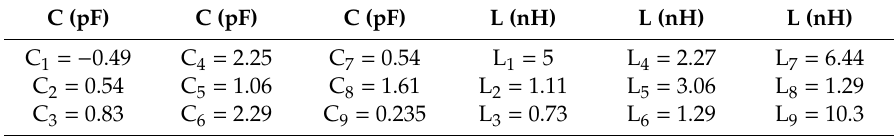
Figure 11. ( a ) Equivalent lumped circuit of the microstrip band stop filter based on gradient line EBGs; ( b ) equivalent lumped circuit of the microstrip band stop filter etched with periodic hexagon ring EBGs. Advanced design system (ADS) is used to simulate the equivalent lumped circuit of the microstrip band stop filter etched with periodic hexagon ring. The LC parameters are optimized as shown in − 10 dB stopband width, which verifies the correctness of the proposed equivalent circuit. Table 1. The extracted parameters in Figure 11b by using advanced design system